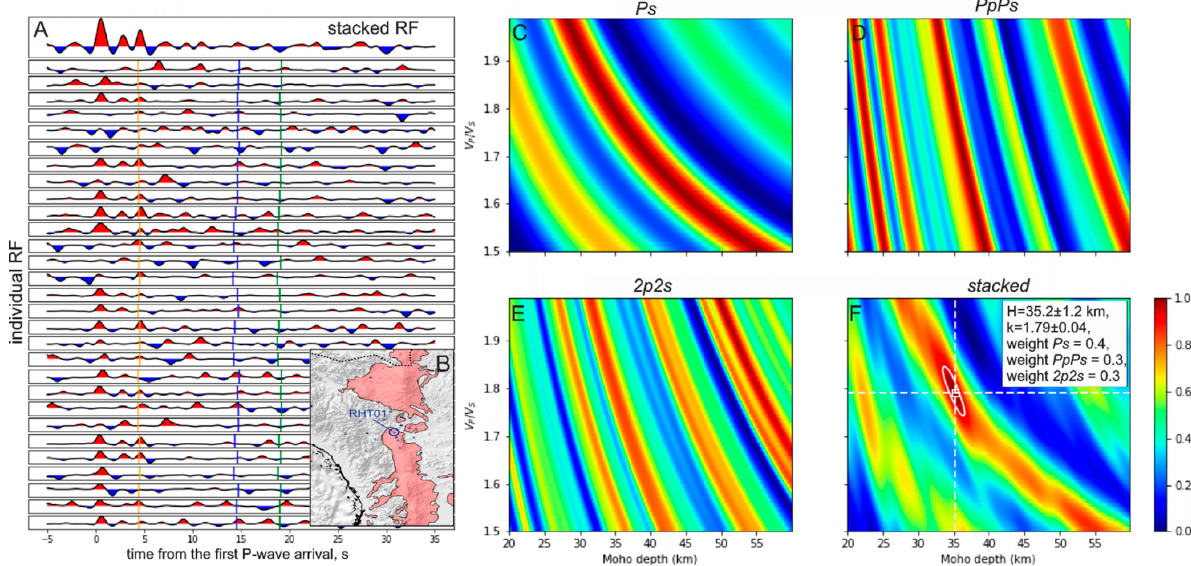
Figure 8. Results of the H-k stacking for the station RHT01 located in the northern part of Harrat– Rahat. ( A ): Individual receiver functions (Q-component). The upper trace is the average of all traces. Red, blue, and green hatches mark the theoretical arrivals of the Ps , PpPs and 2p2s phases, respectively. ( B ). The location of the station on the map. ( C – E ): Grid search results for three individual phases Ps , PpPs and 2p2s . ( F ): Result of stacking of the results for all phases. The white dashed lines mark the best solution. The parameters of stacking and results for H and k determination are shown on the panel F.